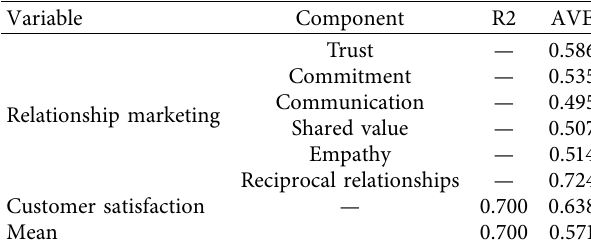
Table 8: Commonality and R2 values of the dependent